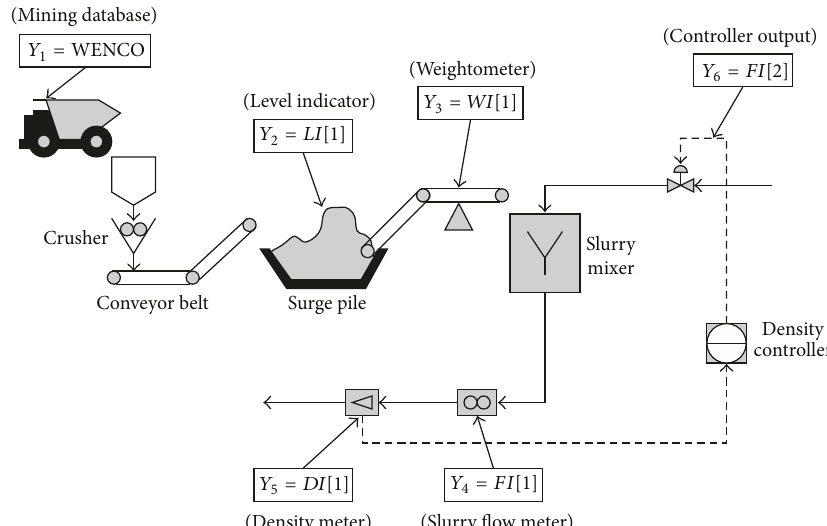
Figure 1: Oil sand solid slurry preparing system [26].